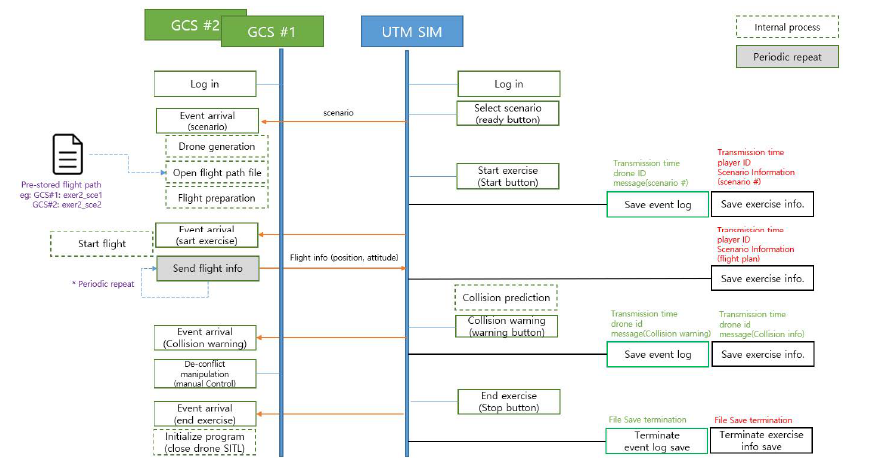
Figure 14. Scenario #2 (deconfliction study by time and altitude).